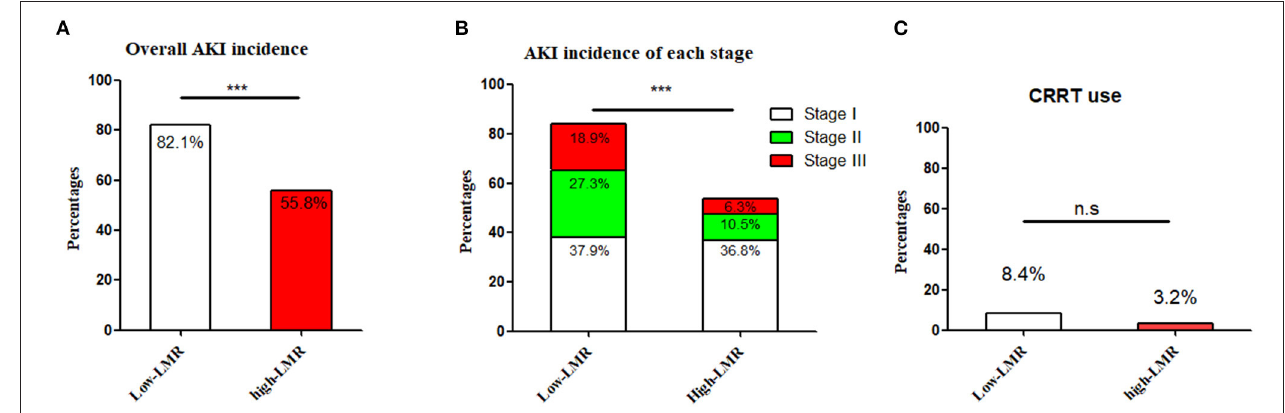
FIGURE 2 | The incidence and severity of post-operative AKI in the low-LMR group and high-LMR group in ADTIAD. Depicts the incidence of AKI and severity (stages 1, 2, and 3) in the low-LMR group and high-LMR group in ADTIAD. (A) Incidence of AKI in the low-LMR group and high-LMR group in ADTIAD. (B) Severity of AKI (stages 1, 2, and 3) in the low-LMR group and high-LMR group in ADTIAD. (C) CRRT use in the low-LMR group and high-LMR group in ADTIAD. AKI, Acute Kidney Injury; LMR, Lymphocyte-to-Monocyte Ratio; CRRT, Continuous Renal Replacement Therapy. *** P < 0.001, n.s., no statistical